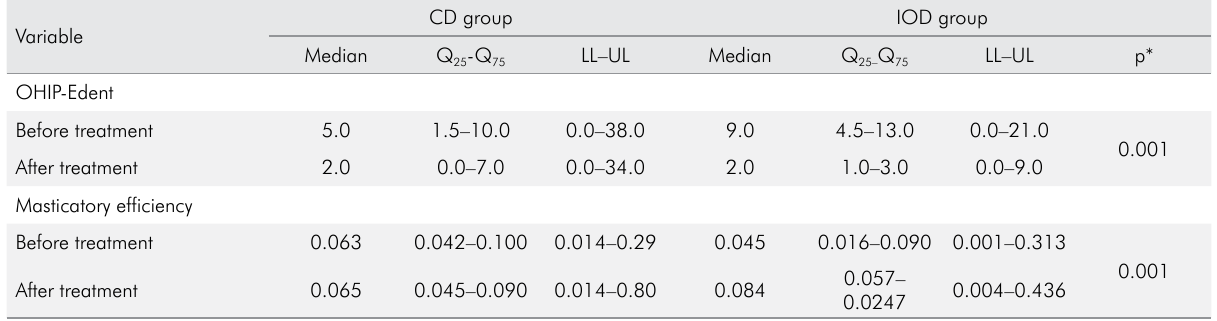
Table 3. OHIP-Edent scores and masticatory efficiency before and after treatment for the conventional denture (CD) and implant overdenture (IOD) groups.